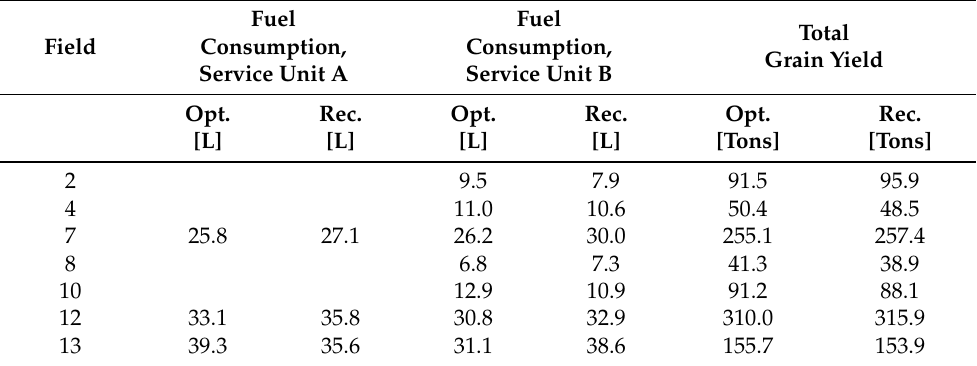
Table 3. Calculated SU fuel consumption and total grain yield comparison between recorded (Rec.) and simulated optimisation (Opt.) of harvest operation per